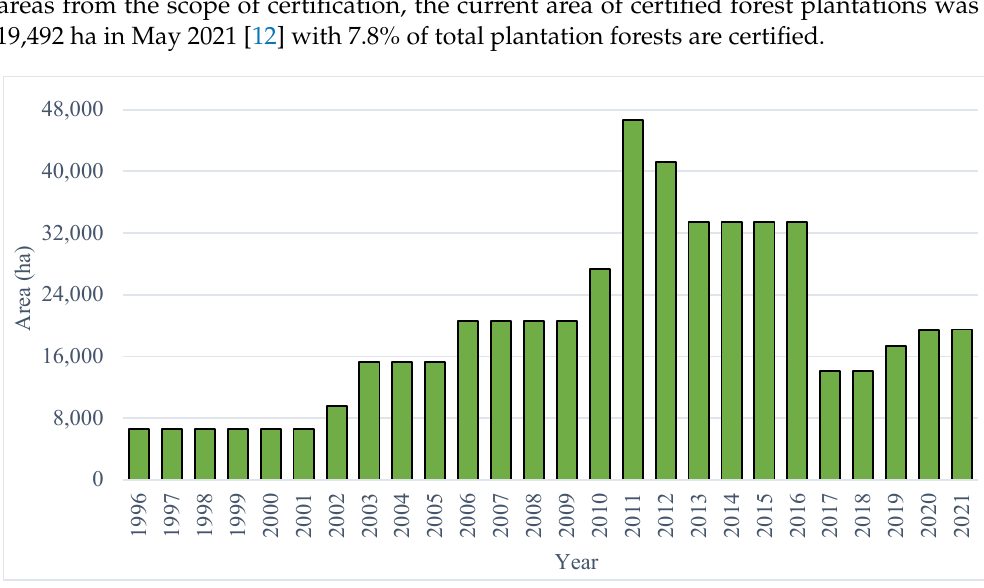
Figure 2. Change in area of FSC certified forest plantations in Sri Lanka (1996 to May 2021). Source: [12].